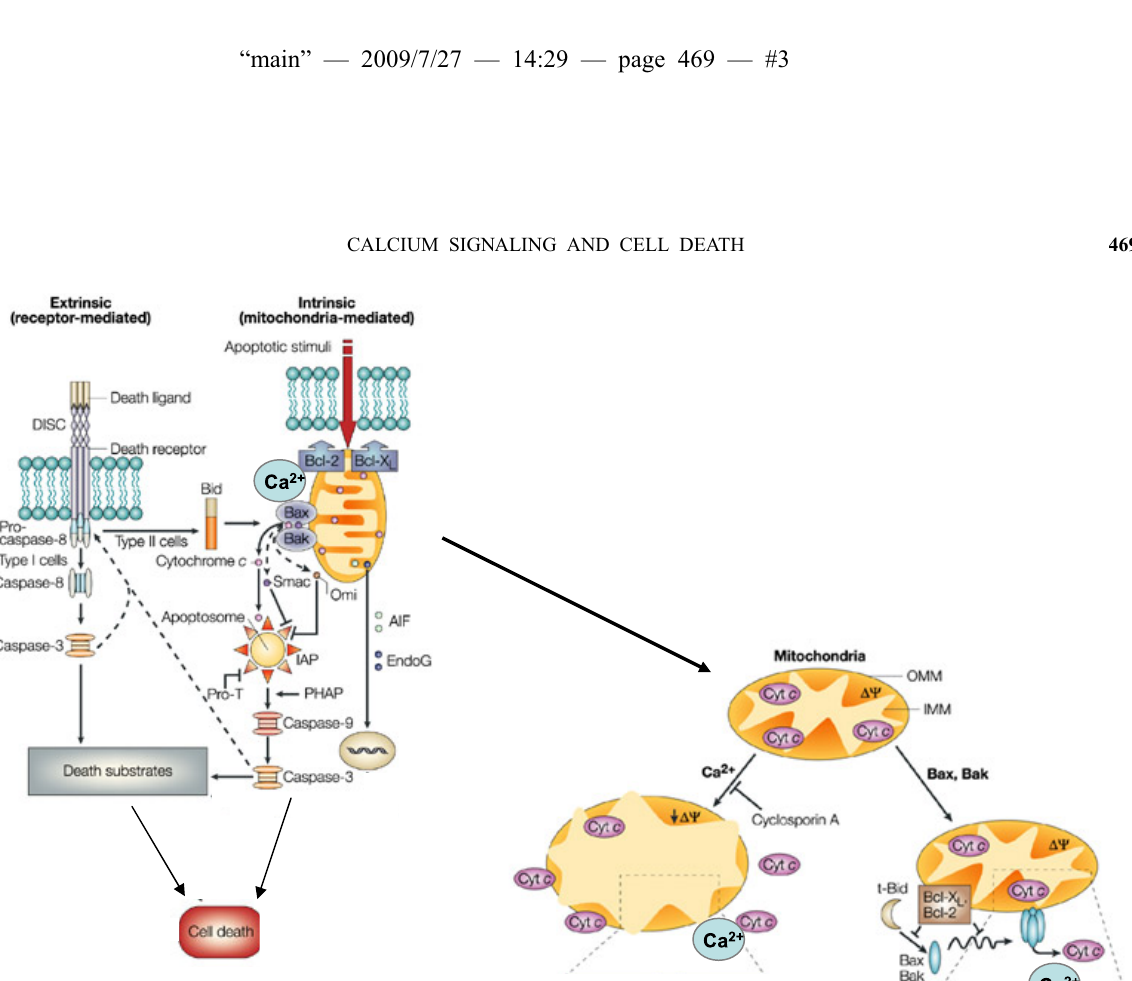
Fig. 1 – The Extrinsic and Intrinsic Pathways of Apoptosis. The extrinsic pathway is a receptor-dependent mechanism in which the activation of the death receptors leads to the formation of death-inducible signaling complex (DISC), activation of caspases 8 followed by a cascade of caspases thatwillexecutecelldeath. Whencaspase-8isactivateditmayleadtoBid(aBH3onlypro-apoptoticprotein)andintrinsicpathwayactivation. The intrinsic pathway is activated by the presence of apoptotic stimuli which may cause Bax translocation to mitochondria. Once in the mitochondria, Bax, together with other pro-apoptotic proteins, activates mechanisms that evoke the release of cytochrome c and other pro-apoptotic factors which lead to caspase-9, caspase-3 and other caspases activation that will execute cell death (Adapted from Orrenius et al. 2003 Nat Rev Mol Cell Biol 4: 552-565). Besides the release of the pro-apoptotic factors, Bax promotes Ca 2 + m mobilization as well (Carvalho et al.